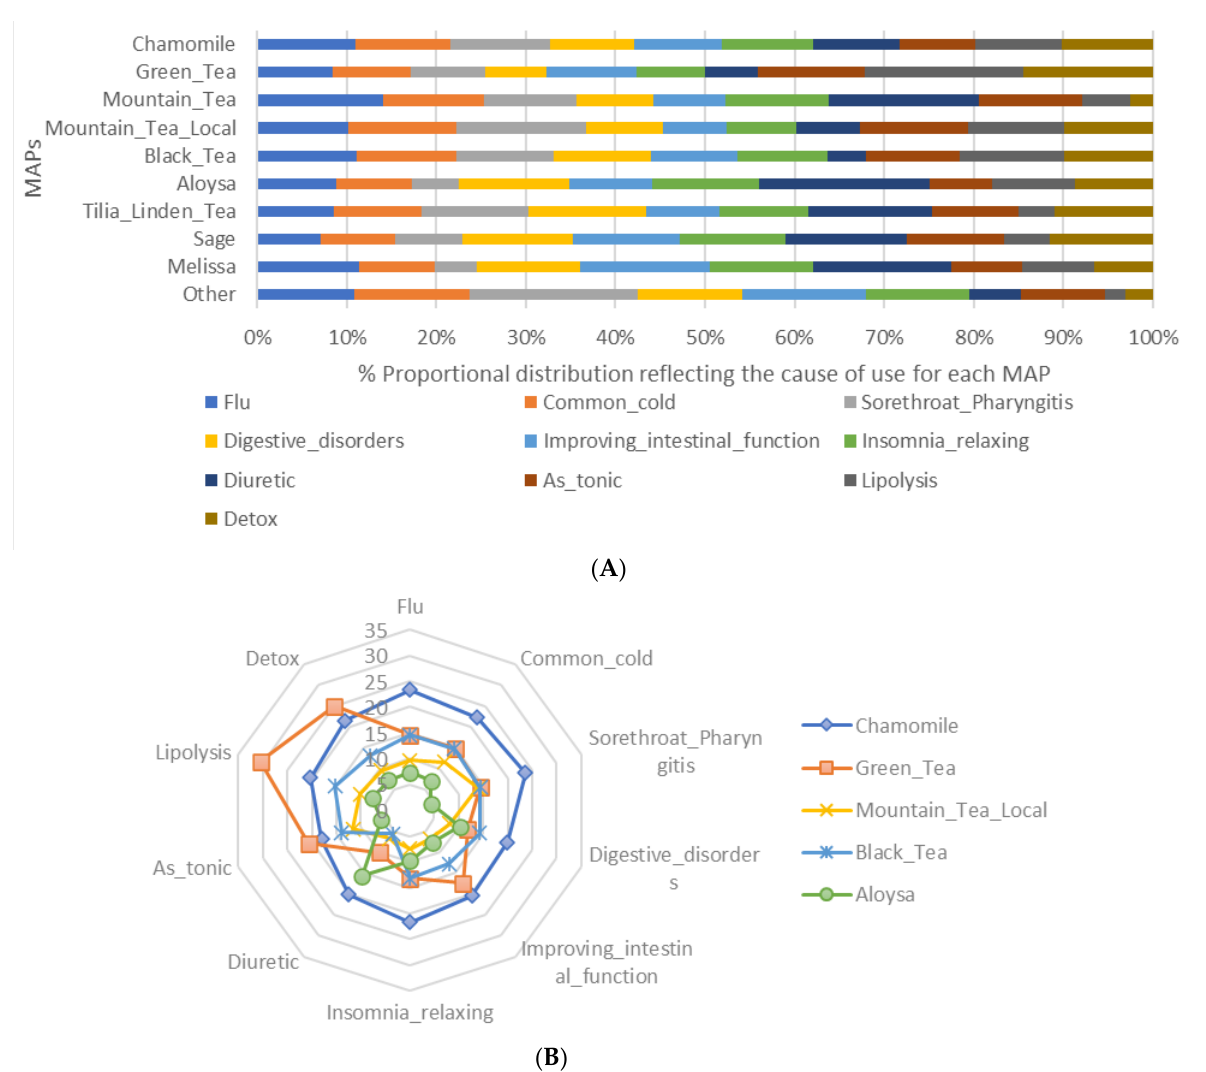
Figure 1. ( A ) % proportional distribution reflecting the cause of use for each MAP, ( B ) ranking of the top 5 MAPs in the conditions.